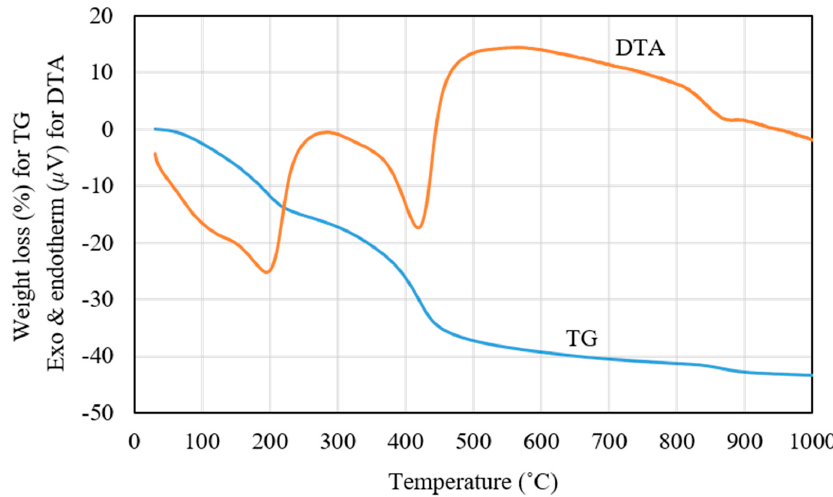
Figure 3. The thermogravimetric analysis (TGA) and differential thermal analysis (DTA) results for Pd 0.016 Mg 3 Al(OH) 16 CO 3 ∙ x H 2 O after drying at 100 °C.